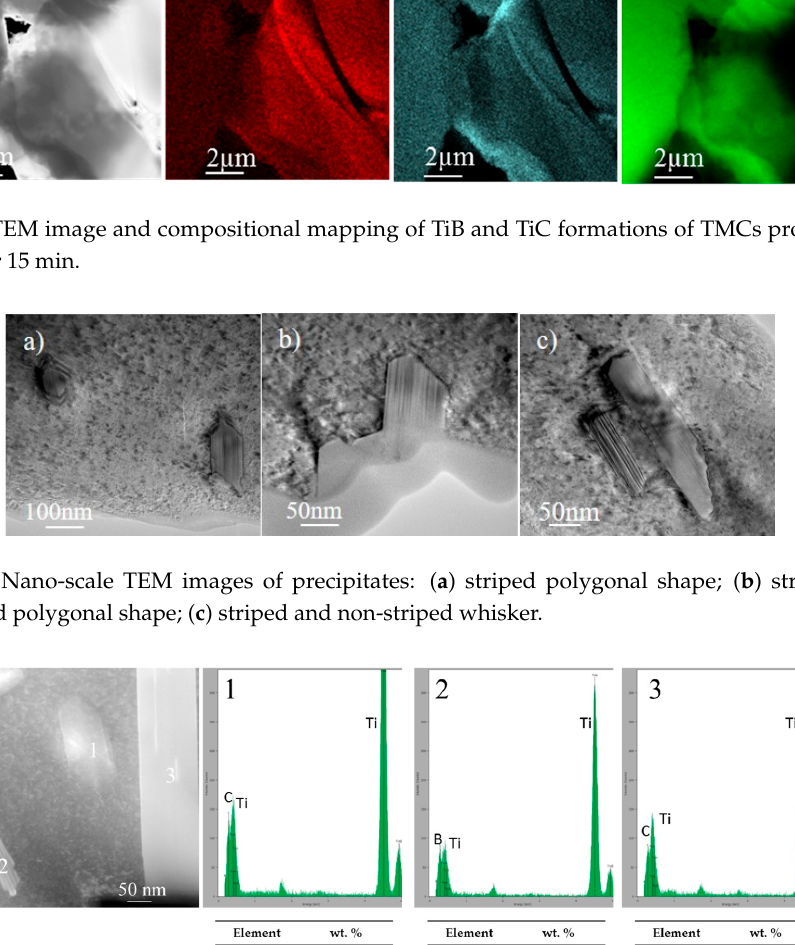
Figure 8. TEM images and EDS (energy dispersive spectroscopy) spectra for different precipitates in Ti matrix.